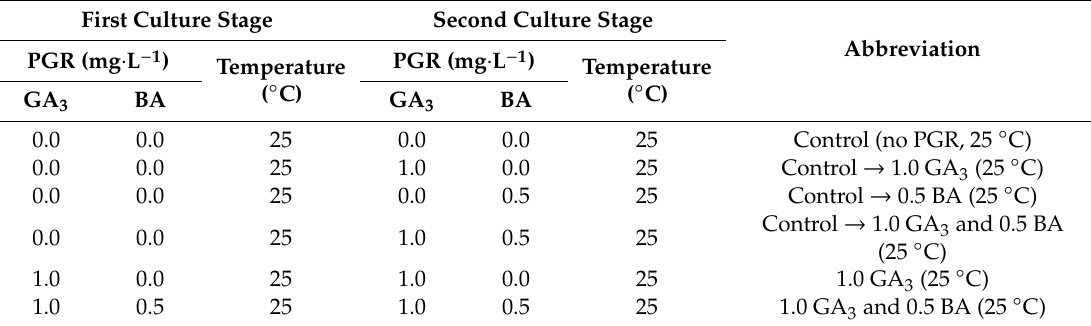
Table 1. The plant growth regulator (PGR) and temperature in the two-stage culture method for breaking the hypocotyl and epicotyl dormancy. Zygotic embryos were cultured for 4 weeks each in the first and second culture